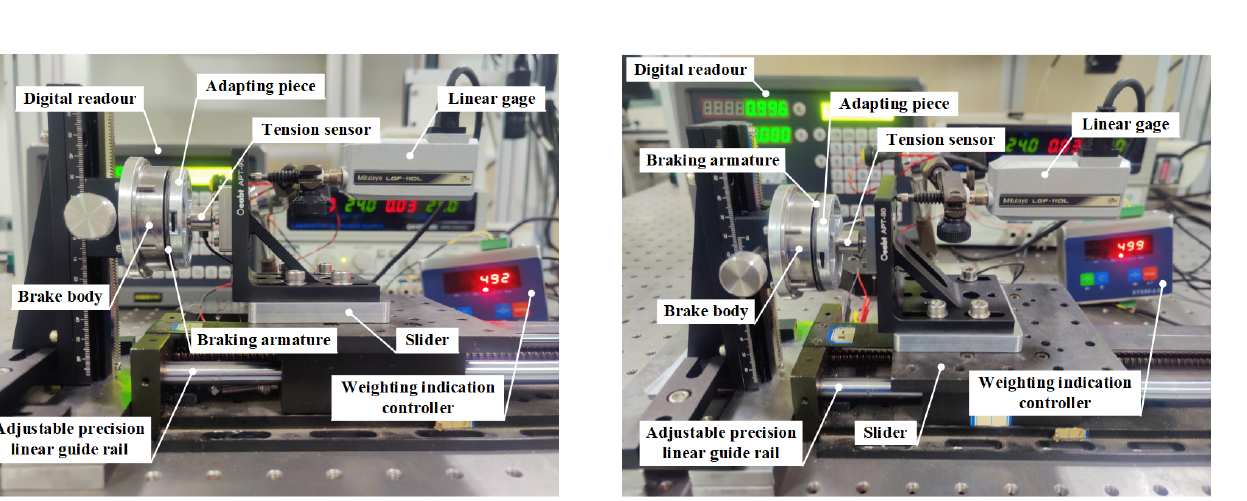
Figure 12. Magnetic circuit in the brake when energising the coil.